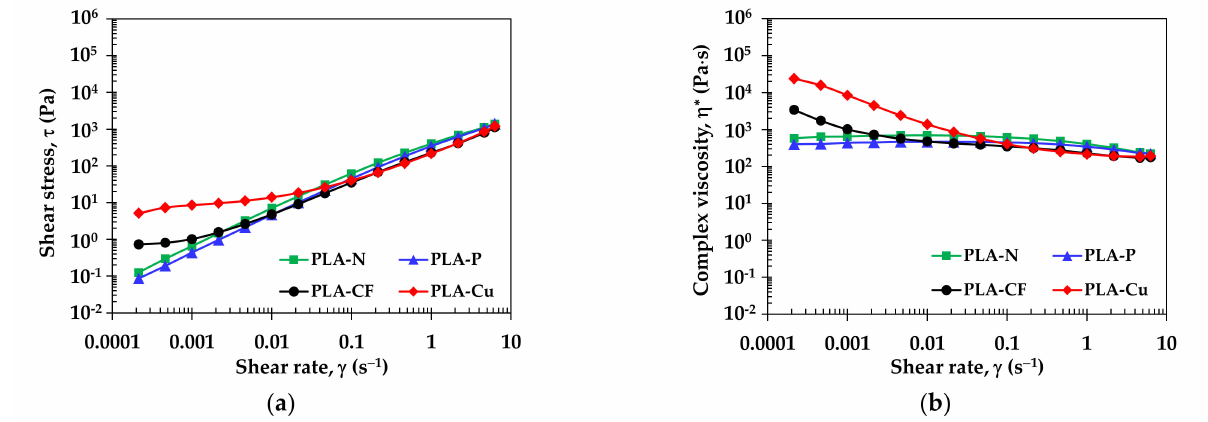
Figure 4. Flow curves of PLA filaments at 210 ◦ C: ( a ) shear stress and ( b ) complex